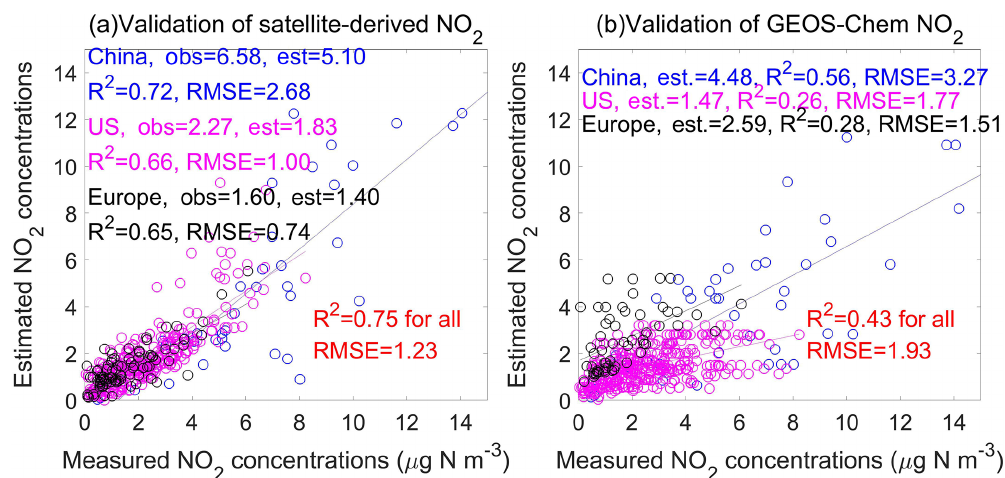
Figure 5. Comparison between annual mean satellite-derived and ground-measured surface NO 2 concentrations (a) and comparison between annual mean modeled (by an ACTM as GEOS-Chem) and ground-measured surface NO 2 concentrations (b) . The ground-based monitoring sites are shown in Fig.